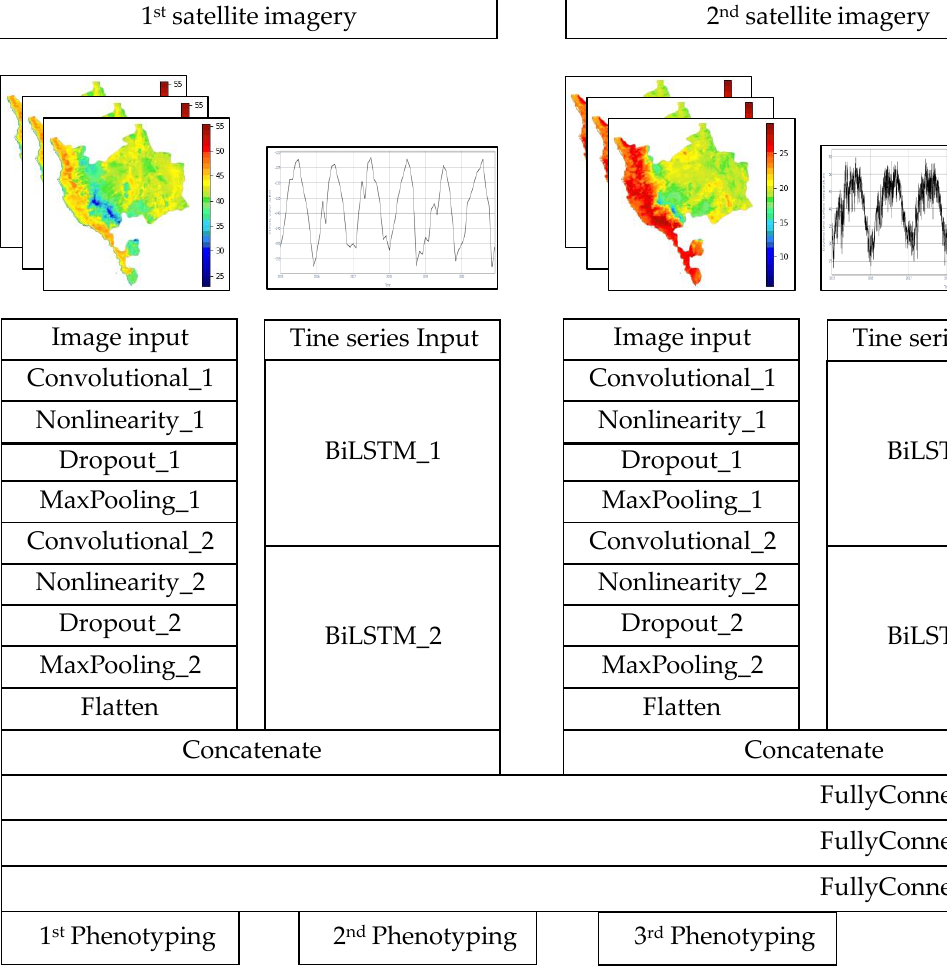
Figure 7. Block diagram of the proposed